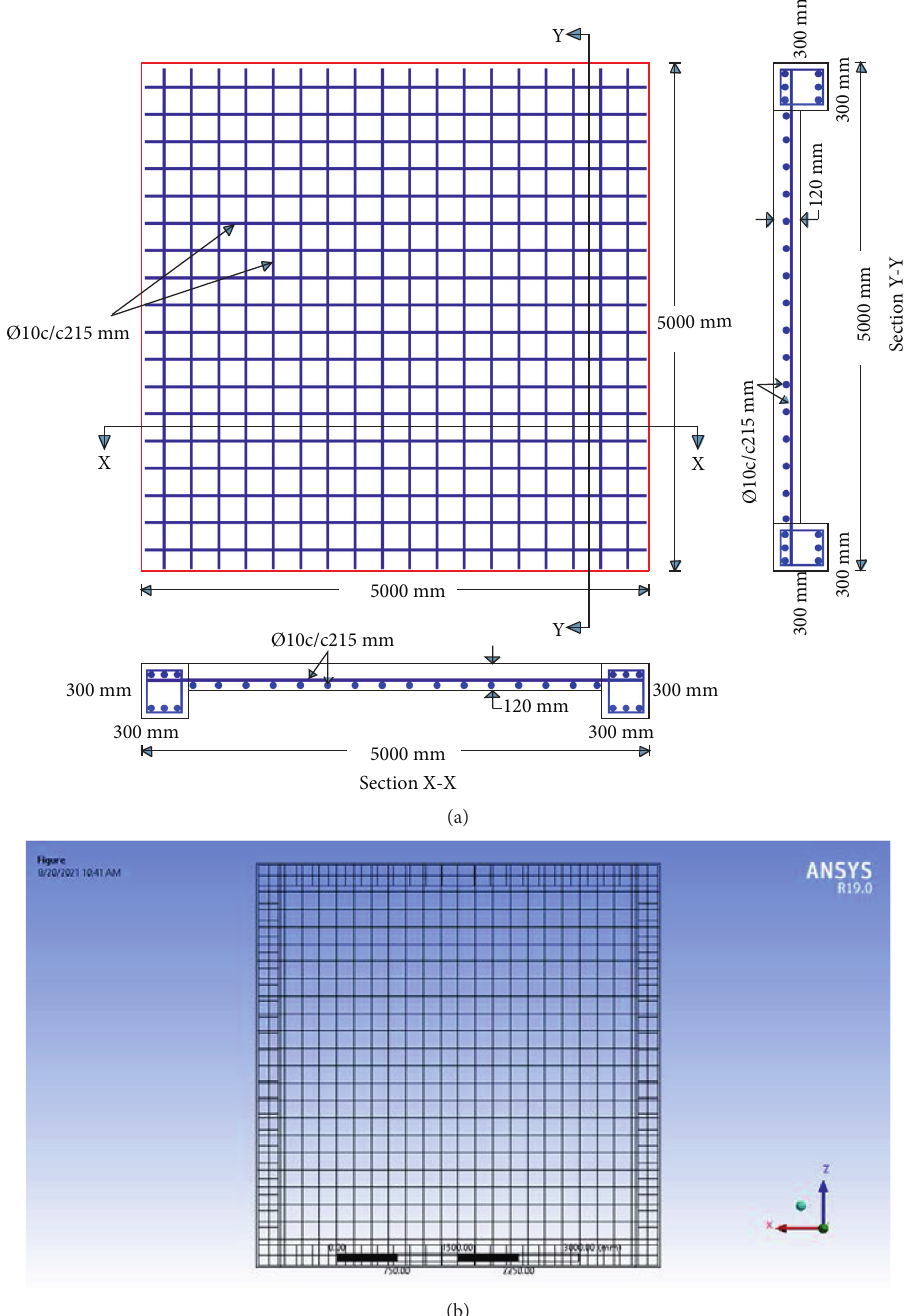
Figure 12: Solid slab reinforcement detailing for FRM_REI_DET_#1, FRM_REI_DET_#2, and FRM_REI_DET_#3 models: (a) sketch; (b) FEA